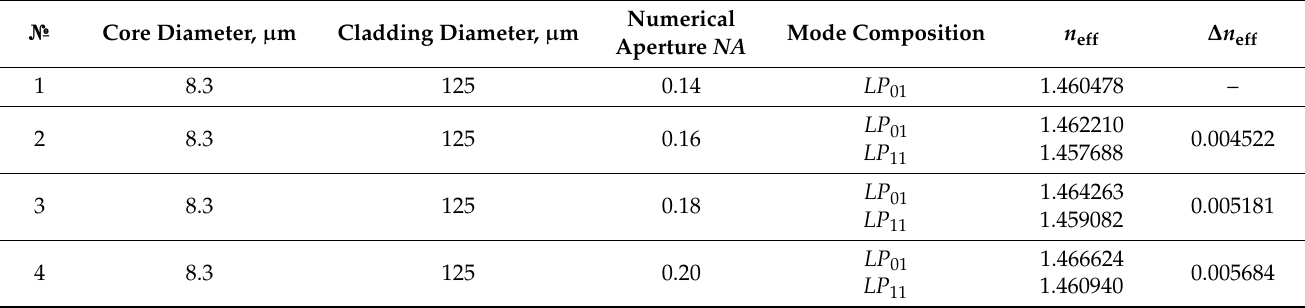
Table 1. Results of optical fiber analysis, performed by rigorous numerical method: step-index optical fibers under various combinations of core diameter and numerical aperture ( λ = 1550